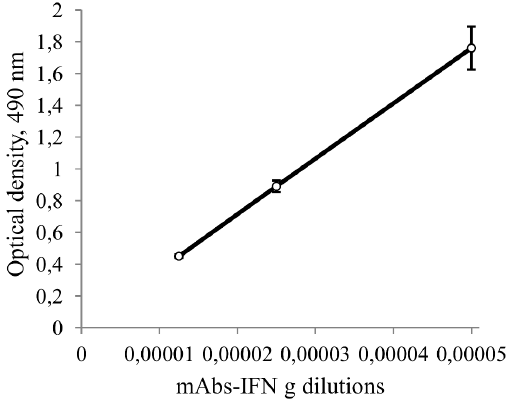
Figure 1. Linear relationship between mAbs to IFN-gamma dilutions and optical density. The concentration of IFN-gamma absorbed on the plate is 1 m g/ml. Dilutions of mAbs are on X axis (where 0.00001 means dilution of starting antibodies to 1:100000 times, 0.00002 means dilution of starting antibodies to 1:50000 times etc.). Optical densities are average values of three measurements. The error bars are the standard deviations.